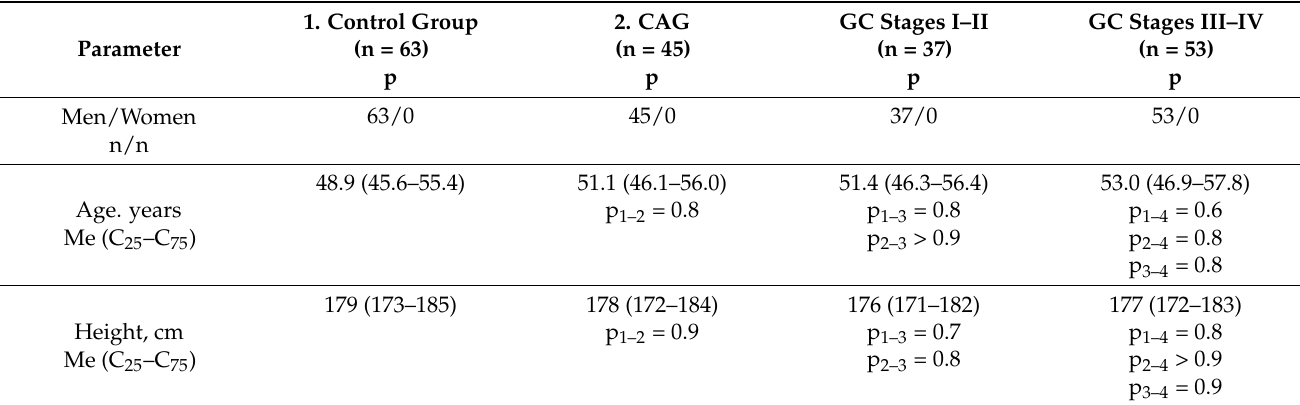
Table 1. Anthropometric and anamnestic characteristics and laboratory parameters of patients with atrophic gastritis and gastric